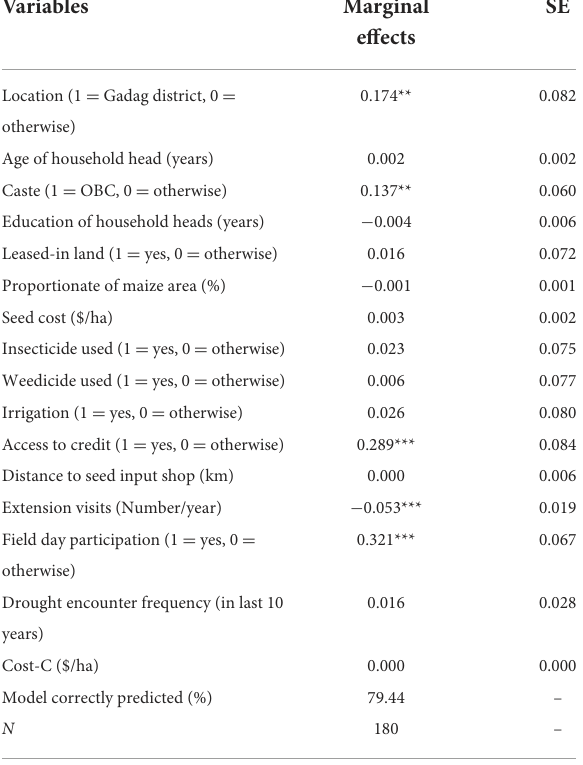
TABLE 4 Factors affecting on the adoption of SR maize hybrids in rain-fed environment (probit).